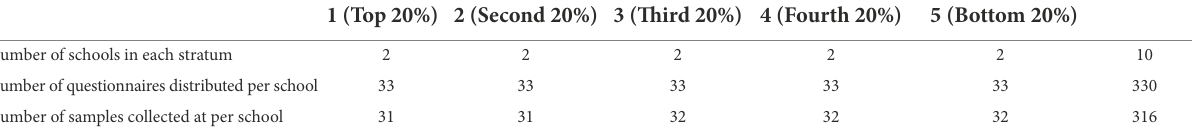
TABLE 1 Detailed information for stratified